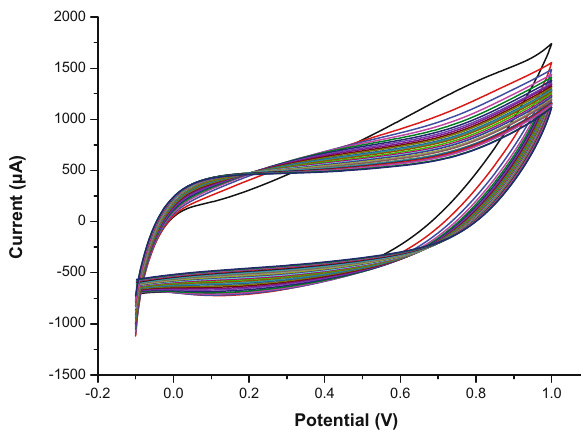
Figure 6: Typical cyclic voltammetric responses of β - gal/GaOx immobilized fi lm of EDOT/Th copolymer to lactose in the bu ff er solution ( pH 6.7 ) .